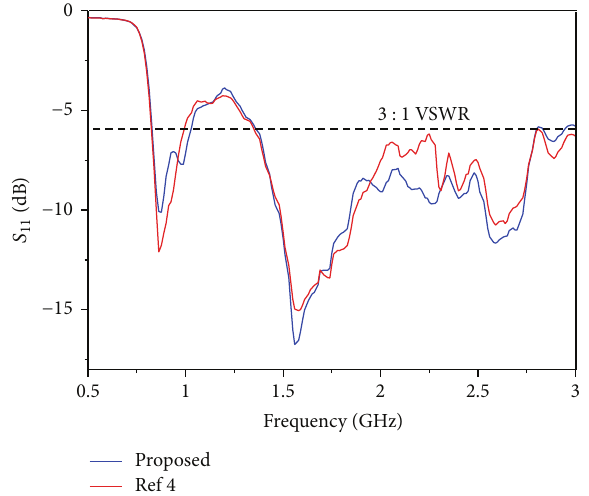
Figure 10: Measured 𝑆 11 result of the proposed antenna and Ref 4 (Ref 4 antenna is the proposed antenna loading of USB and the